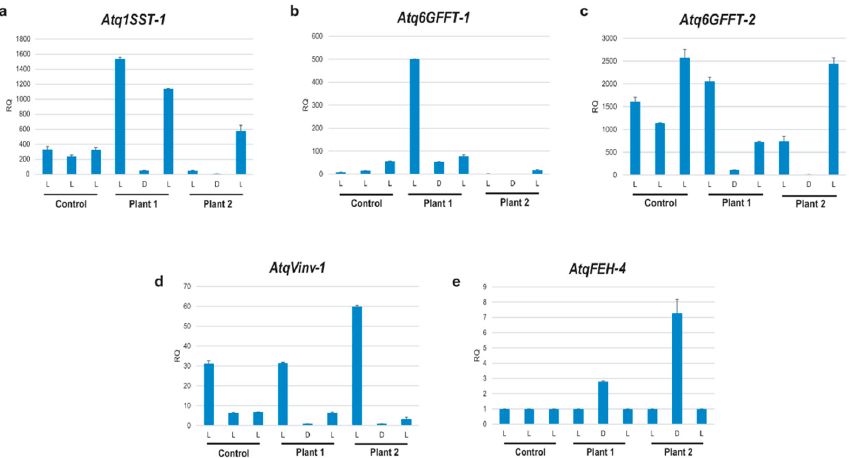
Figure 4. qRT-PCR analysis of PGHF32 genes during light and dark treatments. L, Normal light conditions (16 h light/8 h darkness), D, dark treatment for 7 days. Plants 1 and 2 were placed under